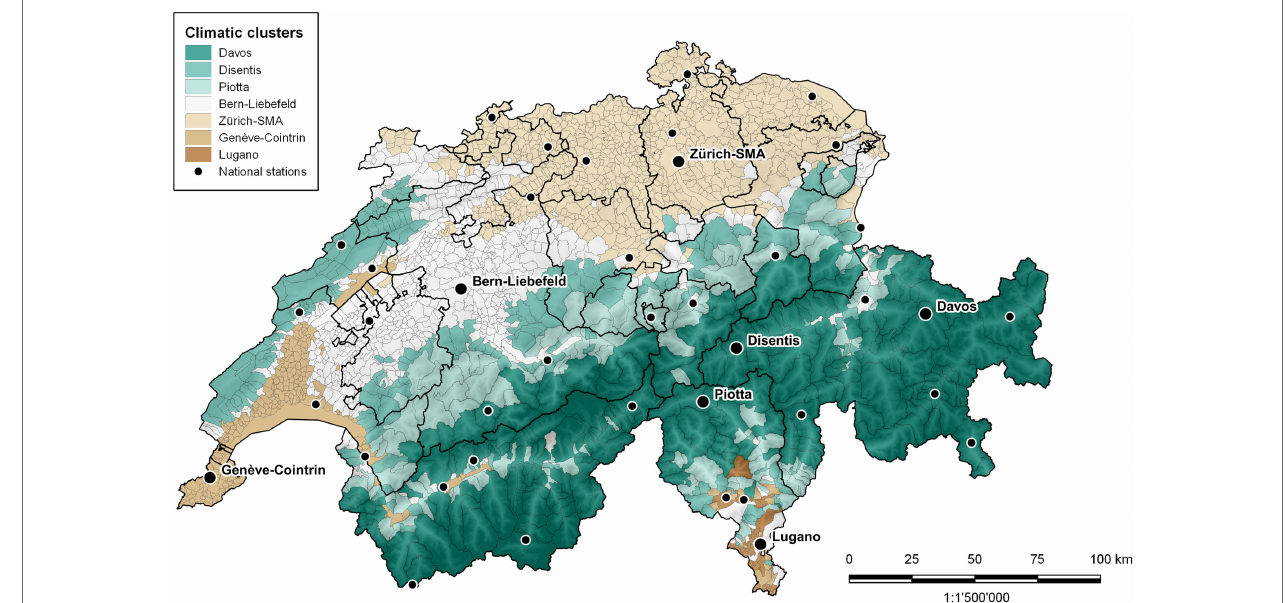
FIGURE 3 | Identified climatic zones in Switzerland.